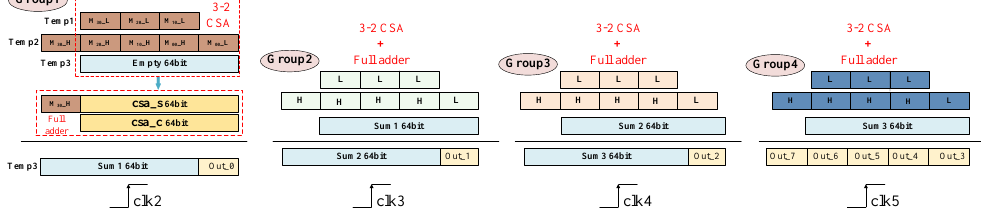
Figure 4. Four steps of the PPA with four clock cycles (Group1 is produced at clk1, and the PPA begins at